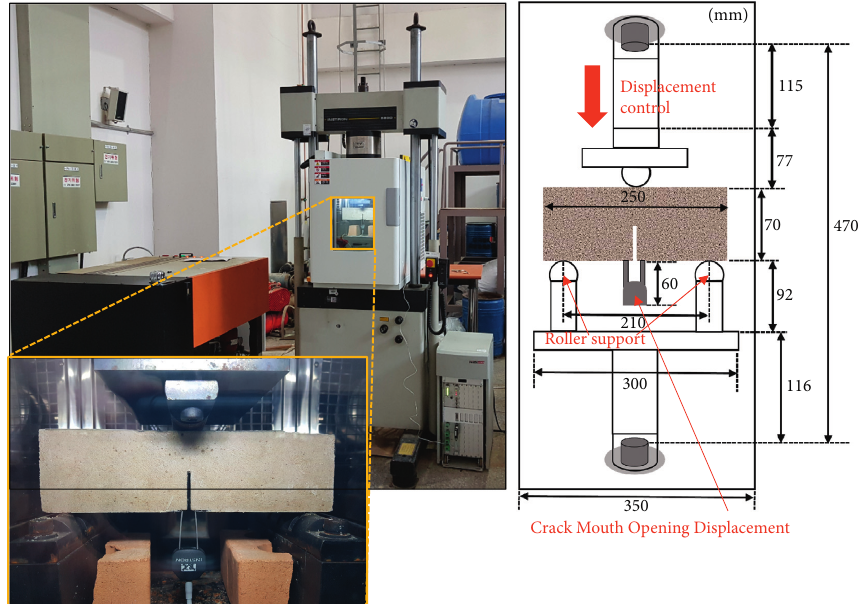
Figure 9: Test procedure and schematic diagram of the three-point bending